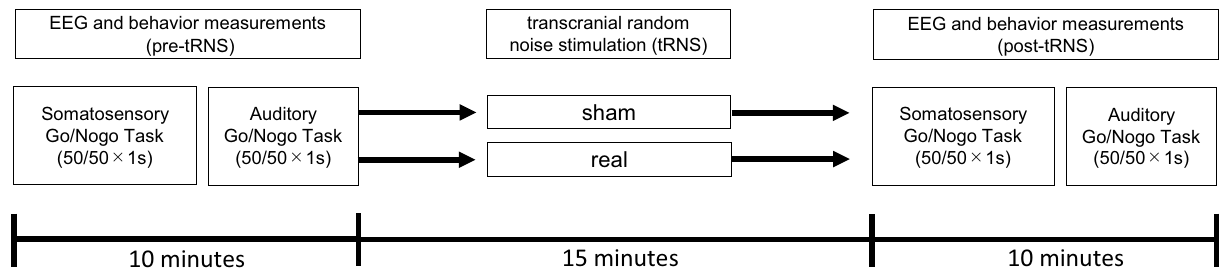
Figure 1. Experimental protocol. Sham and real tRNS sessions were pseudo-randomized in a single-blind